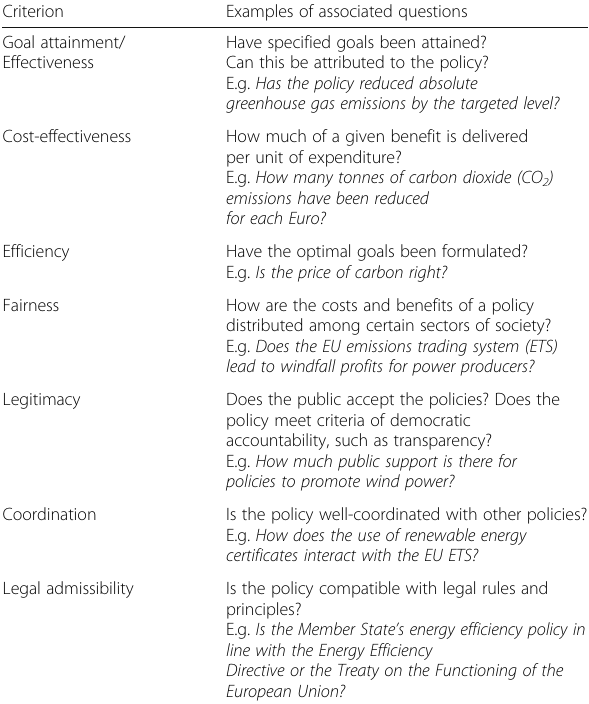
Table 2 List of criteria